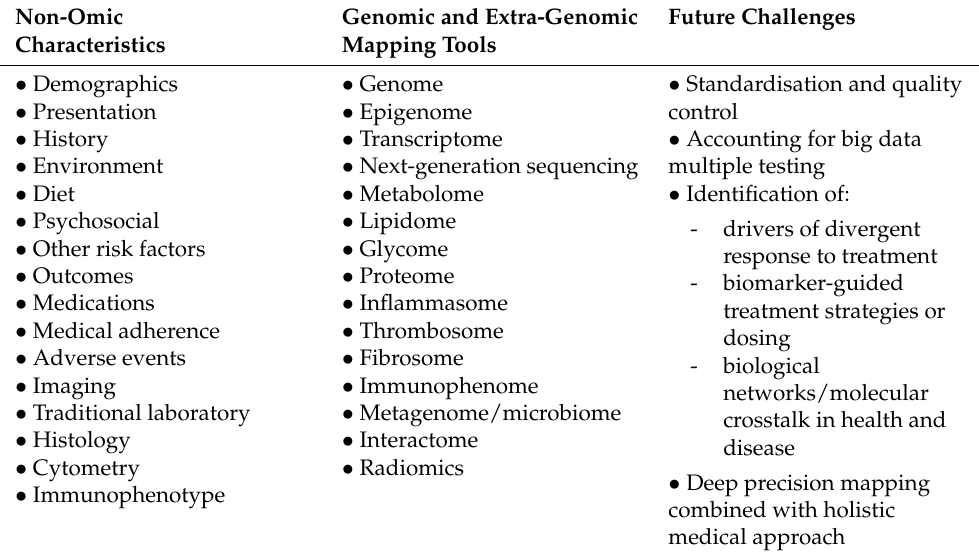
Table 1. Tools and challenges of ACS precision